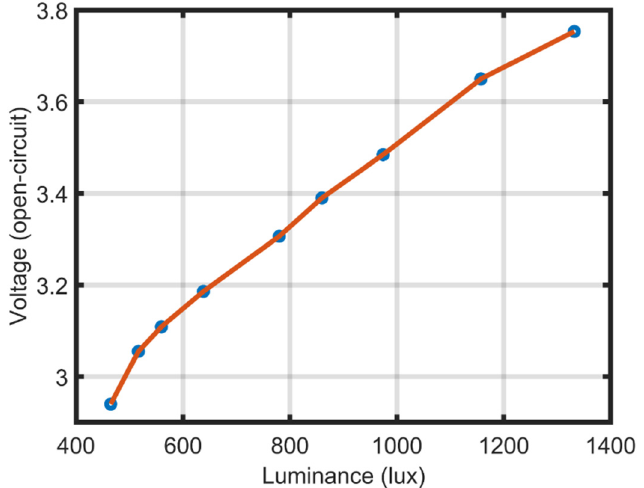
Figure 9. An 11.5 × 23 cm 2 polycrystalline solar panel.